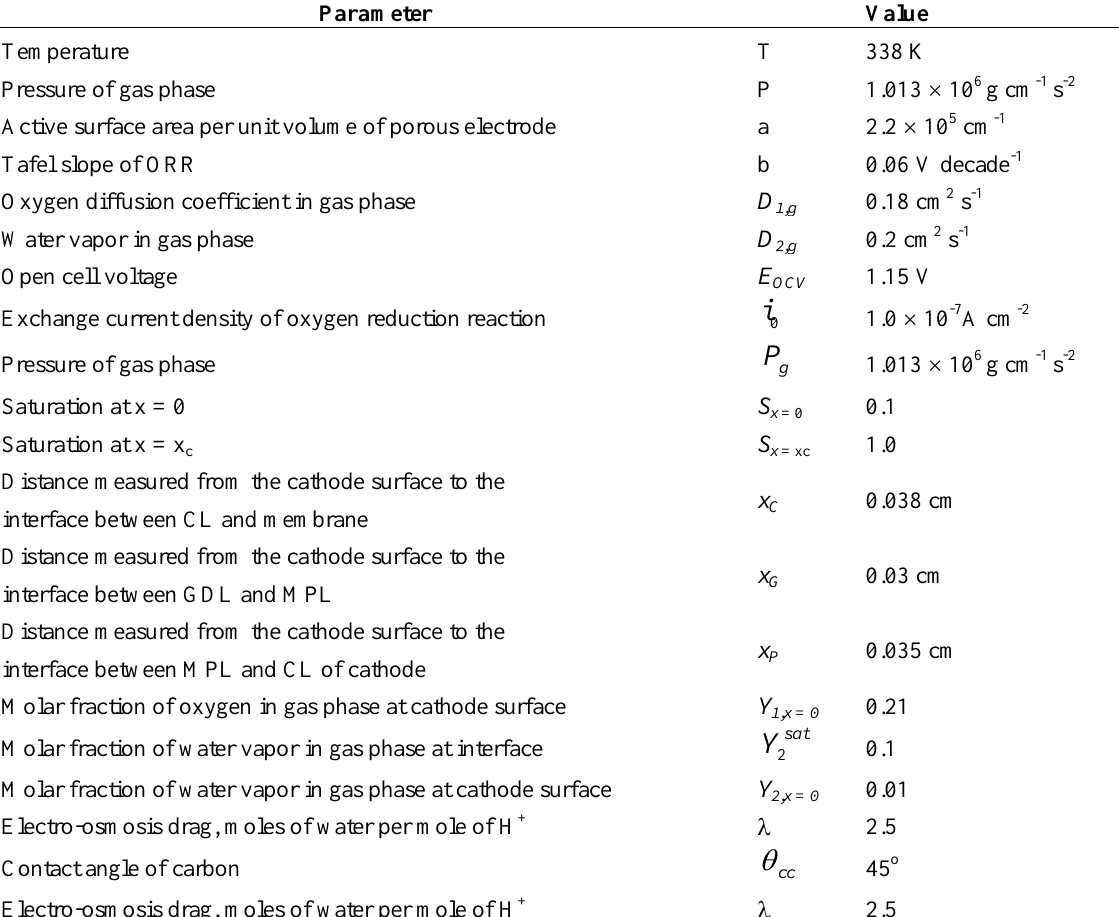
Table 1. Transport and kinetic property values and simulation